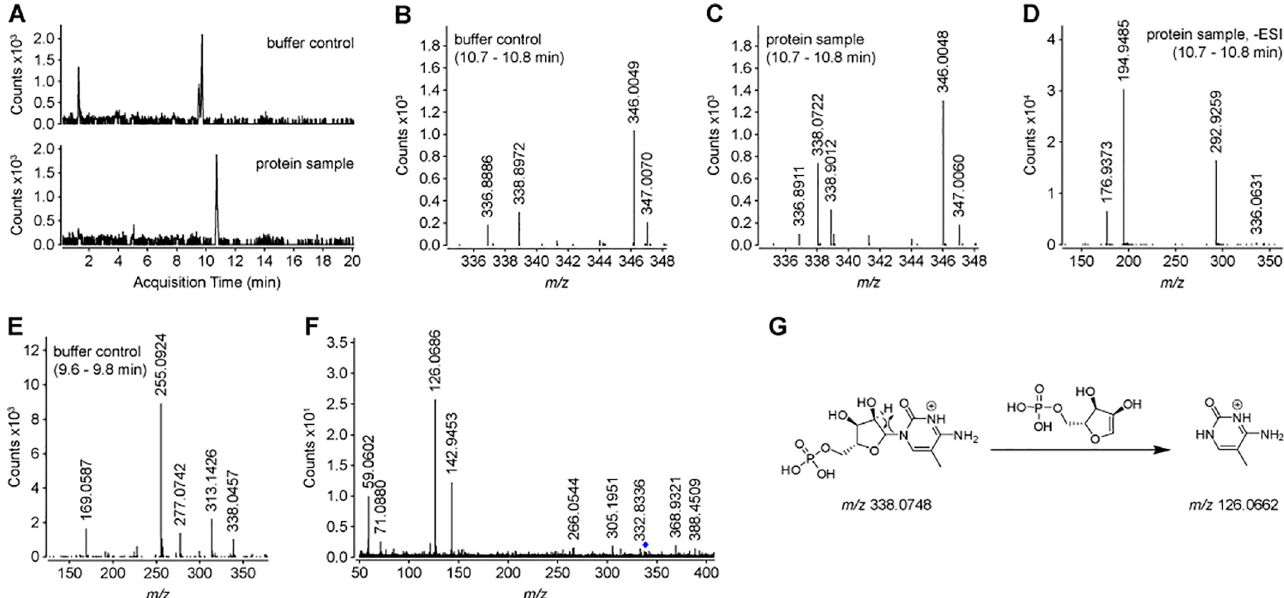
Fig 2. Comparison of mass spectra for buffer-only versus CST protein-containing samples. A) Extracted ion chromatograms for an m/z of 338.0701 ± 0.5 were taken from the LC-MS runs in positive ESI mode (shown in Fig 2 –S1 Fig) and are shown for the buffer-only control (top) or the CST protein-containing sample (bottom). B-E) Mass spectra in either positive (panels B, C, and E) or negative (panel D) ESI modes are shown. Panels B-D show the spectra for the sample eluting from the HPLC column from between 10.7–10.8 min for the buffer-only control (B) or protein-containing samples (C and D). Panel E shows the spectrum for the buffer-only sample eluting from the HPLC column between 9.6–9.8 min. F) Tandem MS/MS was performed on the ion with m/z of 338.0722 from panel C, with a collision energy of 10 eV. A selection filter of 1.3 m/z was used. The black diamond indicates the position of the precursor ion. G) A putative scheme describes the fragmentation of m 5 CMP ([M+H] + = 338.0748) to produce the most prominent ion (m/z of 126.0686) in the MS/MS spectrum shown in panel F.